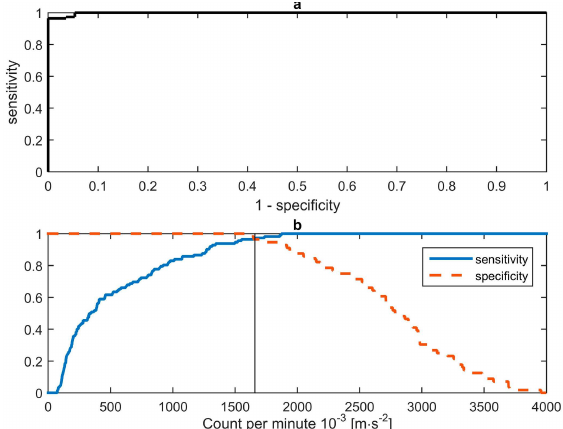
Figure 1. Boxplots of count per minute for the active and sedentary tasks ( n = 14). ( a ) sitting; ( b ) doing deskwork; ( c ) sitting “restless”; ( d ) rising from a chair and walking; ( e ) walking; and ( f ) standing still.